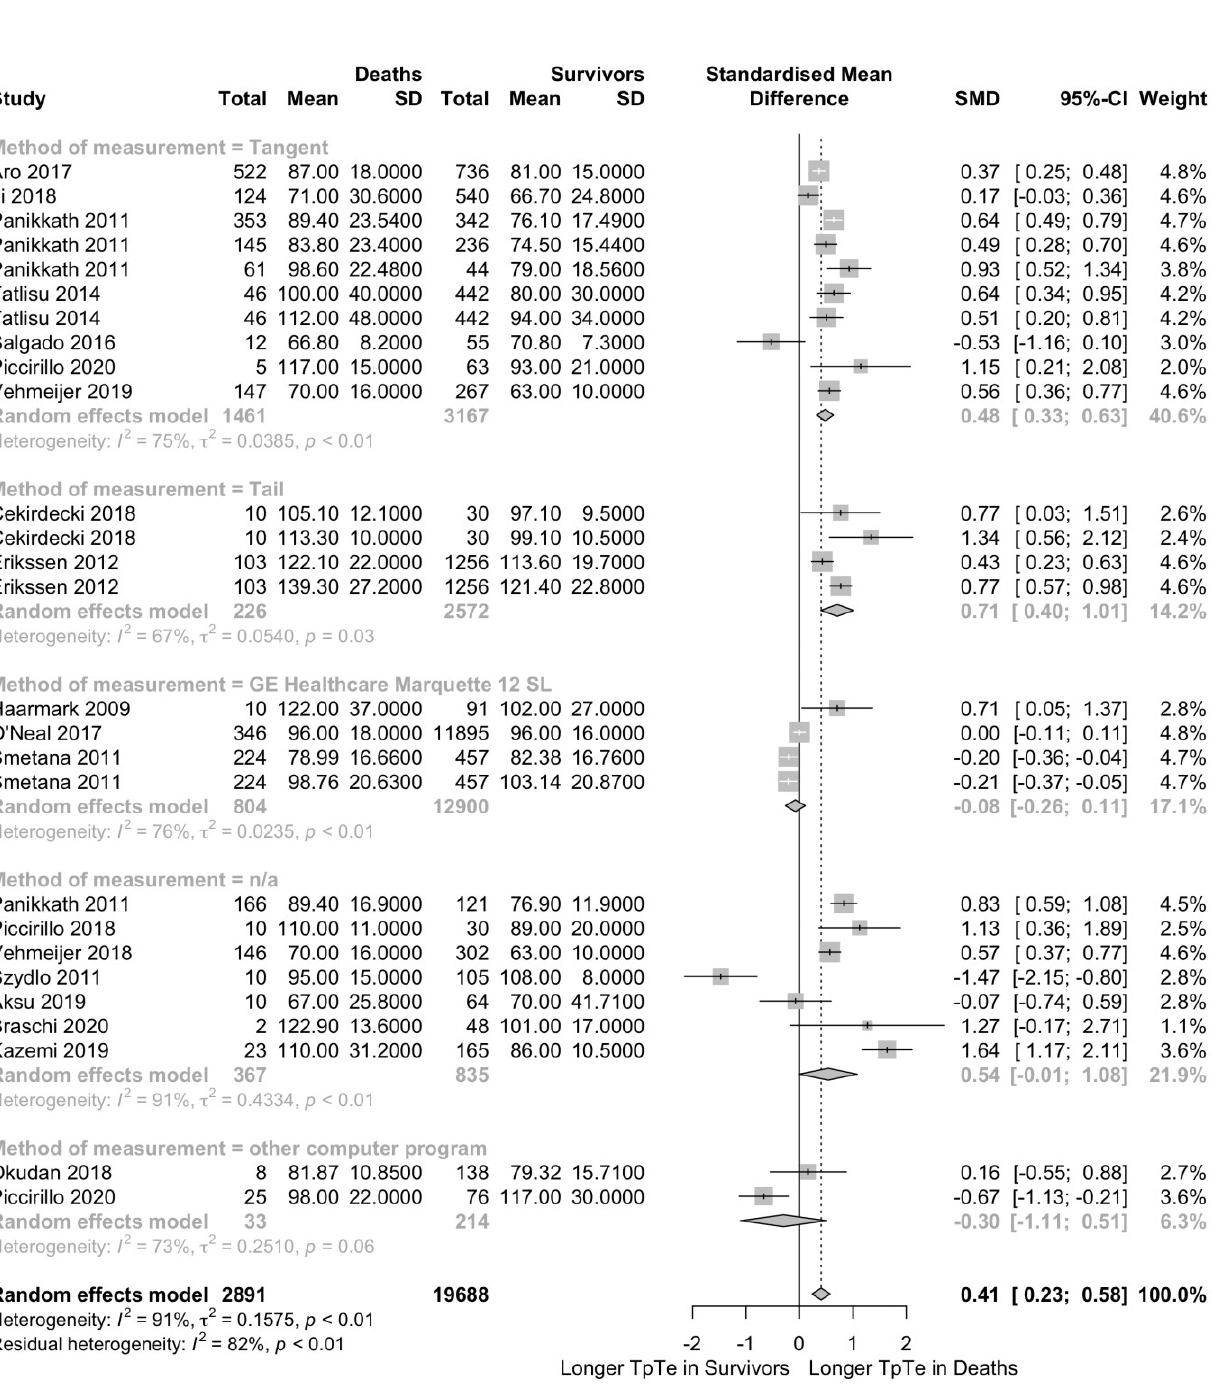
Figure 3. T peak -T end interval is longer in patients who died compared to survivors. This forest plot presents the same studies as Figure 2 but categorized by the ECG measuring method to determine the T peak -T end interval [25,27,29,30 – 32,34,35,37 – 39,40 – 43,46,49 – 53]. To account for possible bias by study design or study quality, we conducted two post-hoc sensitivity analyses. Both a sensitivity analysis restricted to 11 studies with a prospective cohort study design including 17,063 patients, and a sensitivity analysis re- stricted to 12 studies with a Newcastle-Ottawa Quality Assessment Scale score greater six, including 19,842 patients, confirmed the finding. In both prospective cohort studies and